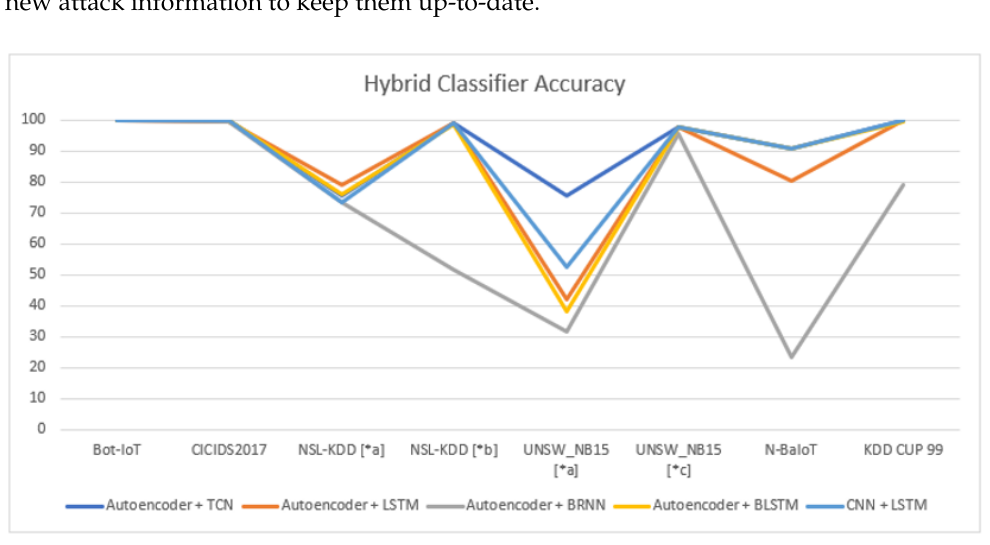
Figure 5. Hybrid classifier models’ accuracy.